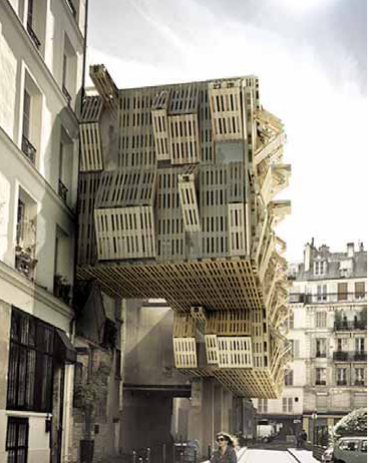
Fig. 23. Wooden wave, London, United Fig. 24. The project AME LOT,